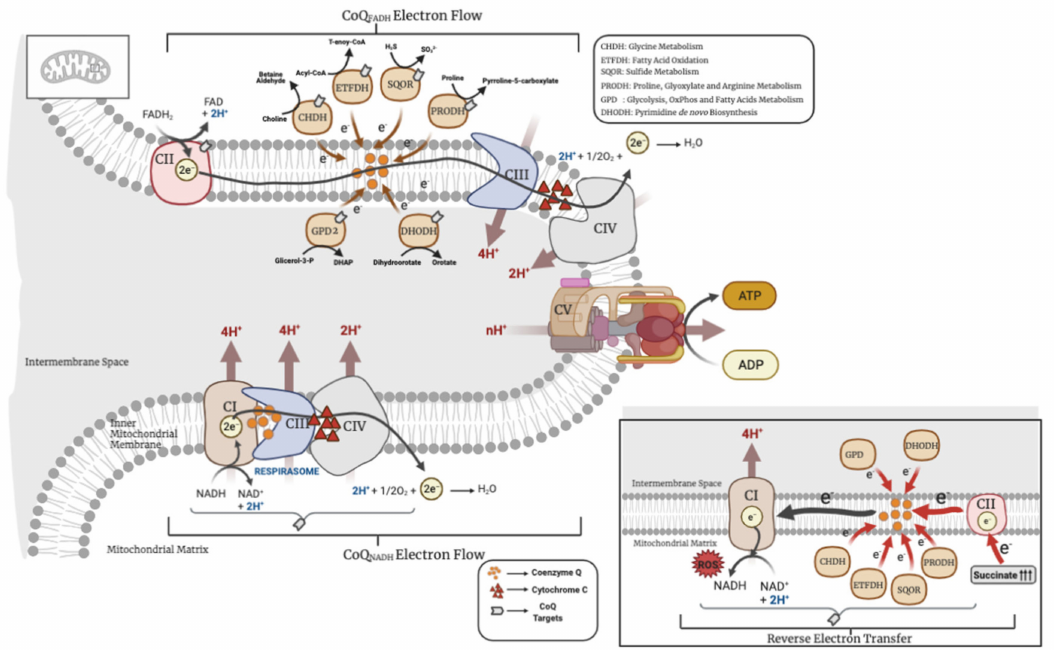
Figure 1. Metabolic uses of coenzyme Q (CoQ) in mitochondria. CHDH = choline dehydrogenase; ETFDH = electron transfer flavoprotein dehydrogenase; SQOR = sulfide:quinone oxidoreductase; PRODH = proline dehydrogenase; GPD2 = glycerol phosphate dehydrogenase; DHODH = dihydroorotate dehydrogenase. The above image represents the forward electron transport and the image below, the reverse electron transport